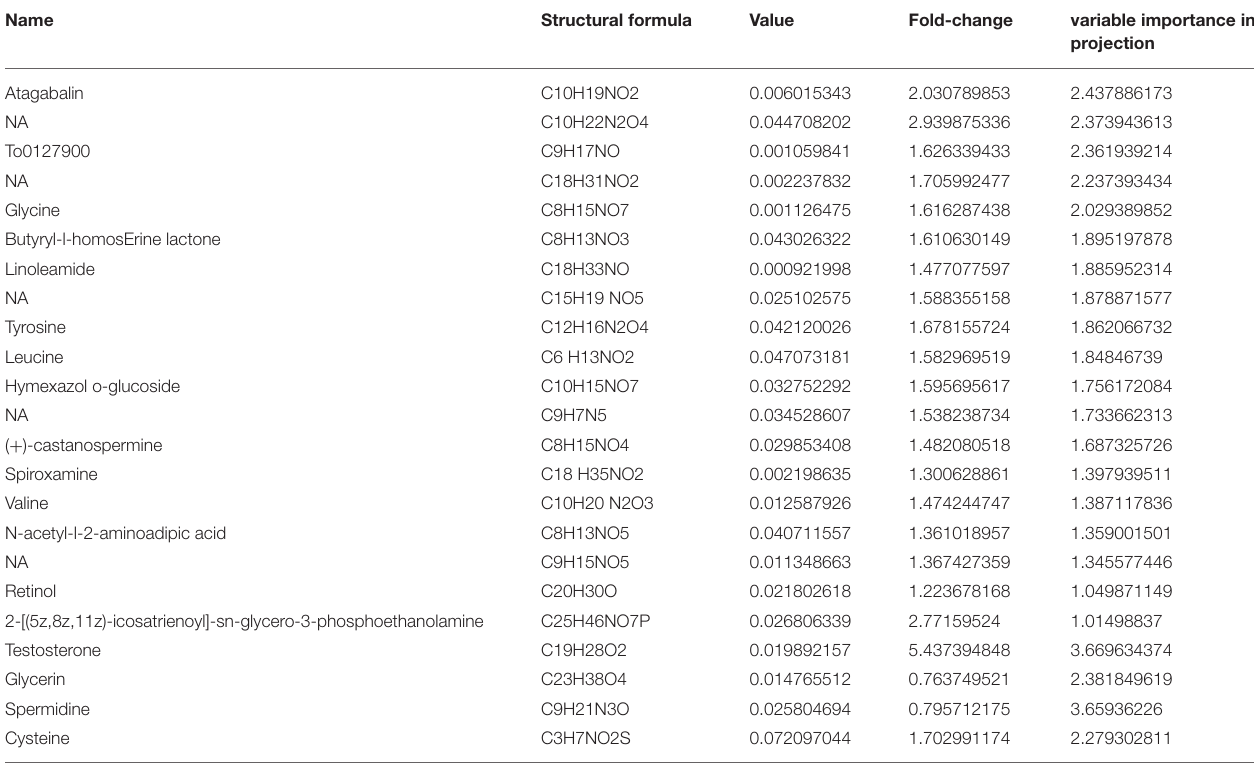
TABLE 1 | A total of 23 differential metabolites in brain were significantly regulated by ACE treatment for its protective effect (VIP ≥ 1, Fold-Change ≥ 1.2 or ≤ 0.83, p -value <